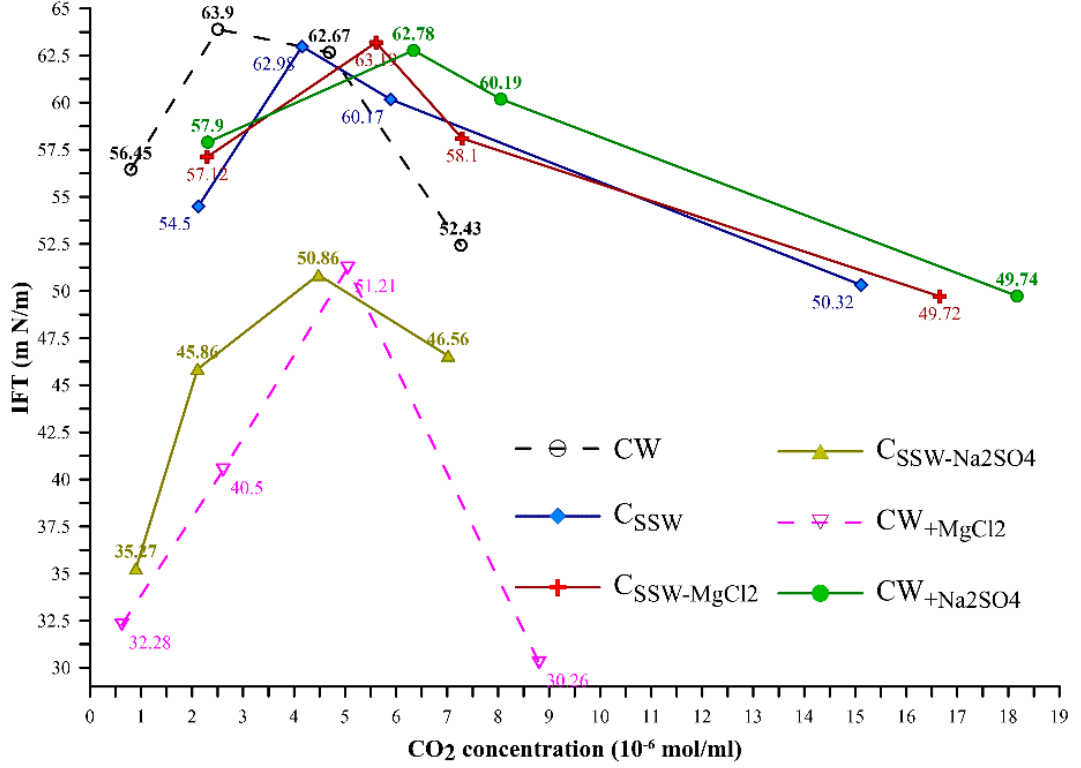
Figure 7. IFT as a function of CO 2 concentration in the n-decane.